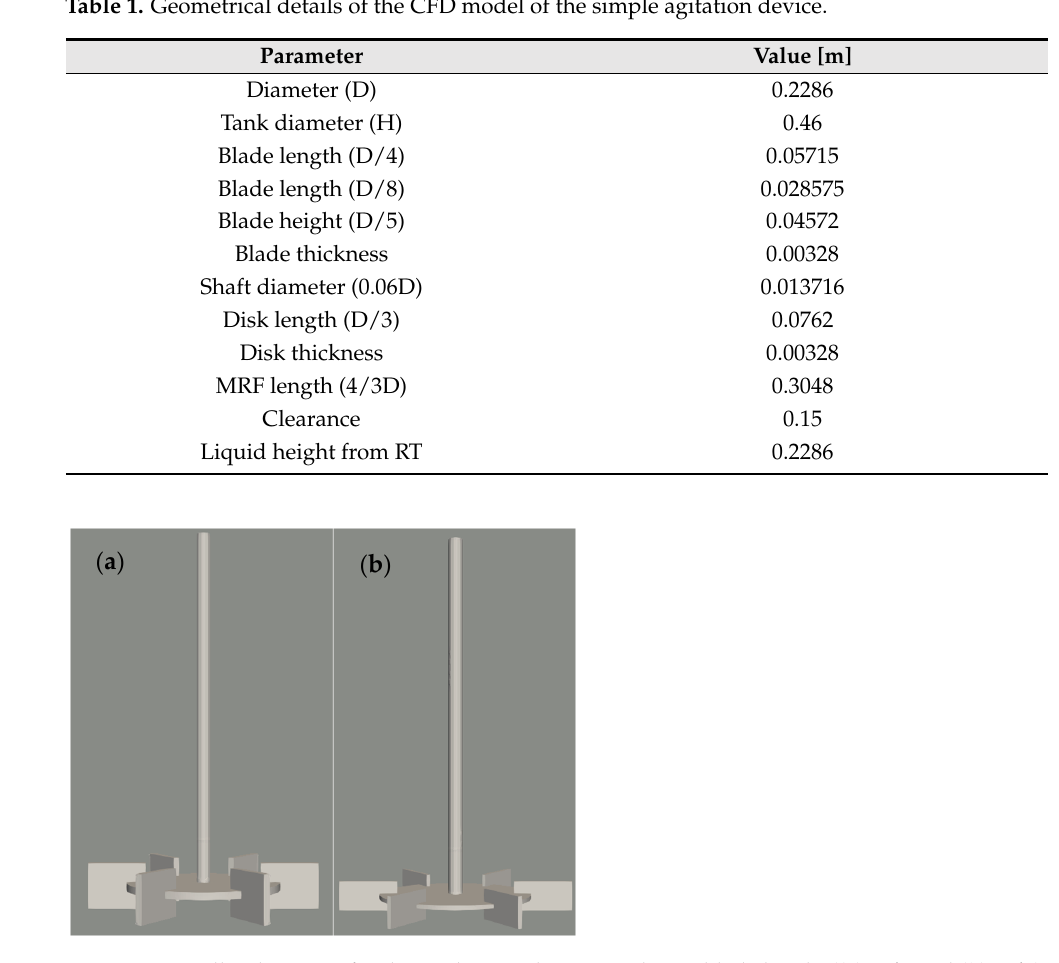
Figure 1. Impeller drawings for the Rushton turbine considering blade height (( a ) D/4 and ( b ) D/8).